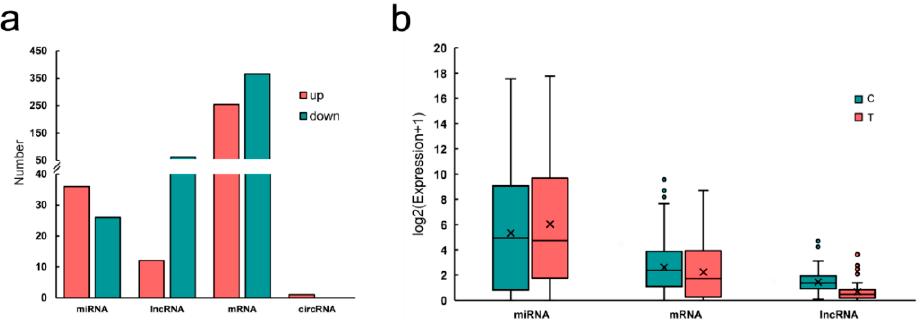
Figure 2. ( a ) The number of up/down regulation of different type RNAs in pigeon crop. ( b ) Cumulative distribution of RNA expression.